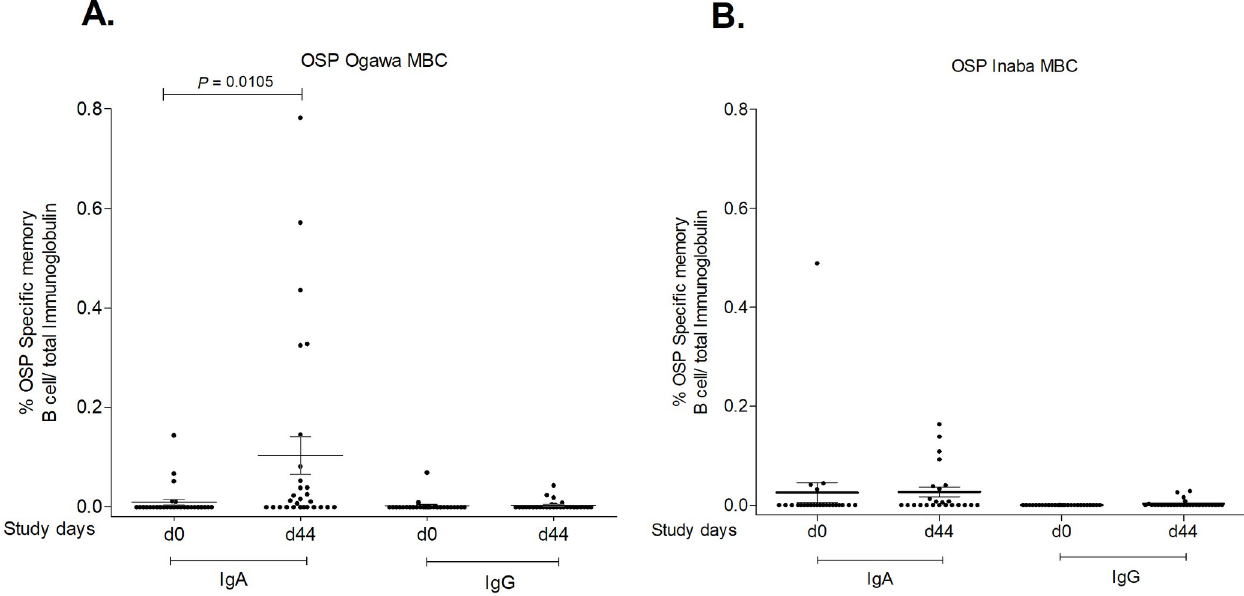
Fig 4. OSP- specific IgA and IgG memory B cell responses. Figure contains mean antigen-specific IgA and IgG memory B cell responses to Ogawa (A) and Inaba (B) OSP, as a percentage of total memory B cells on the same days, with error bars representing standard errors of the means (mean ± SEM). The Wilcoxon signed-rank test was used for analyses of the data. P value is indicated where a statistically significant difference was found from baseline (day 0).